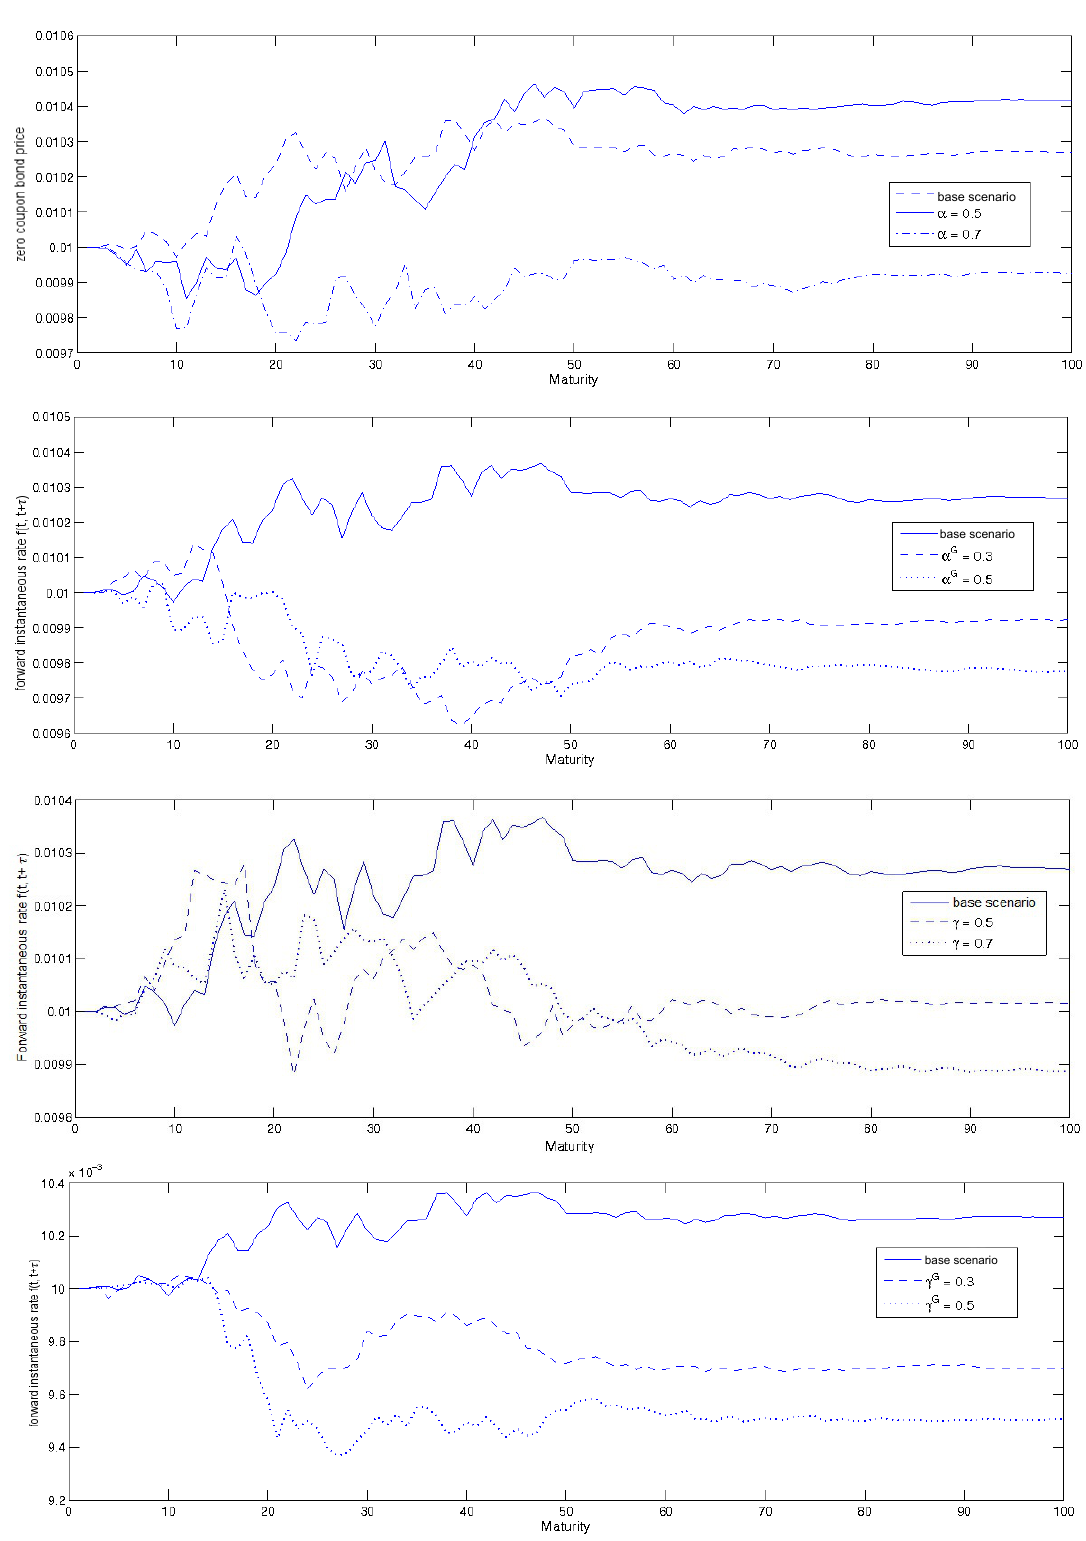
Figure 8. Forward instantaneous rate for various levels of correlation coefficients α , ¯ α , γ , ¯ γ